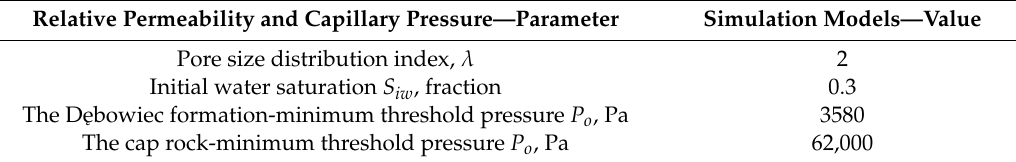
Table 2. Characteristics of relative permeability and capillary pressure in the simulation models.